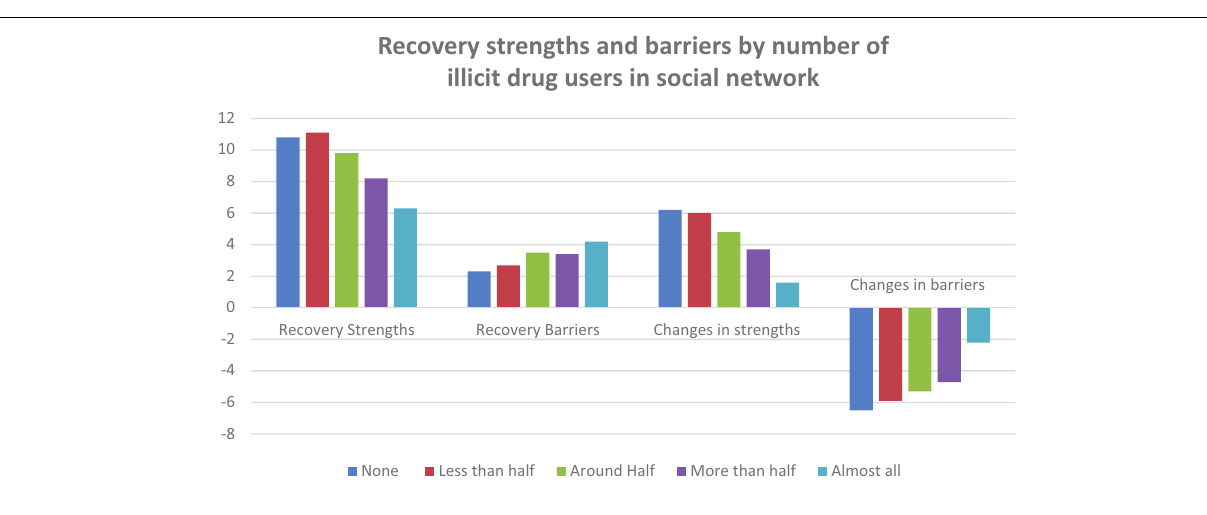
FIGURE 1 | Strengths and barriers in recovery by important people to talk to.